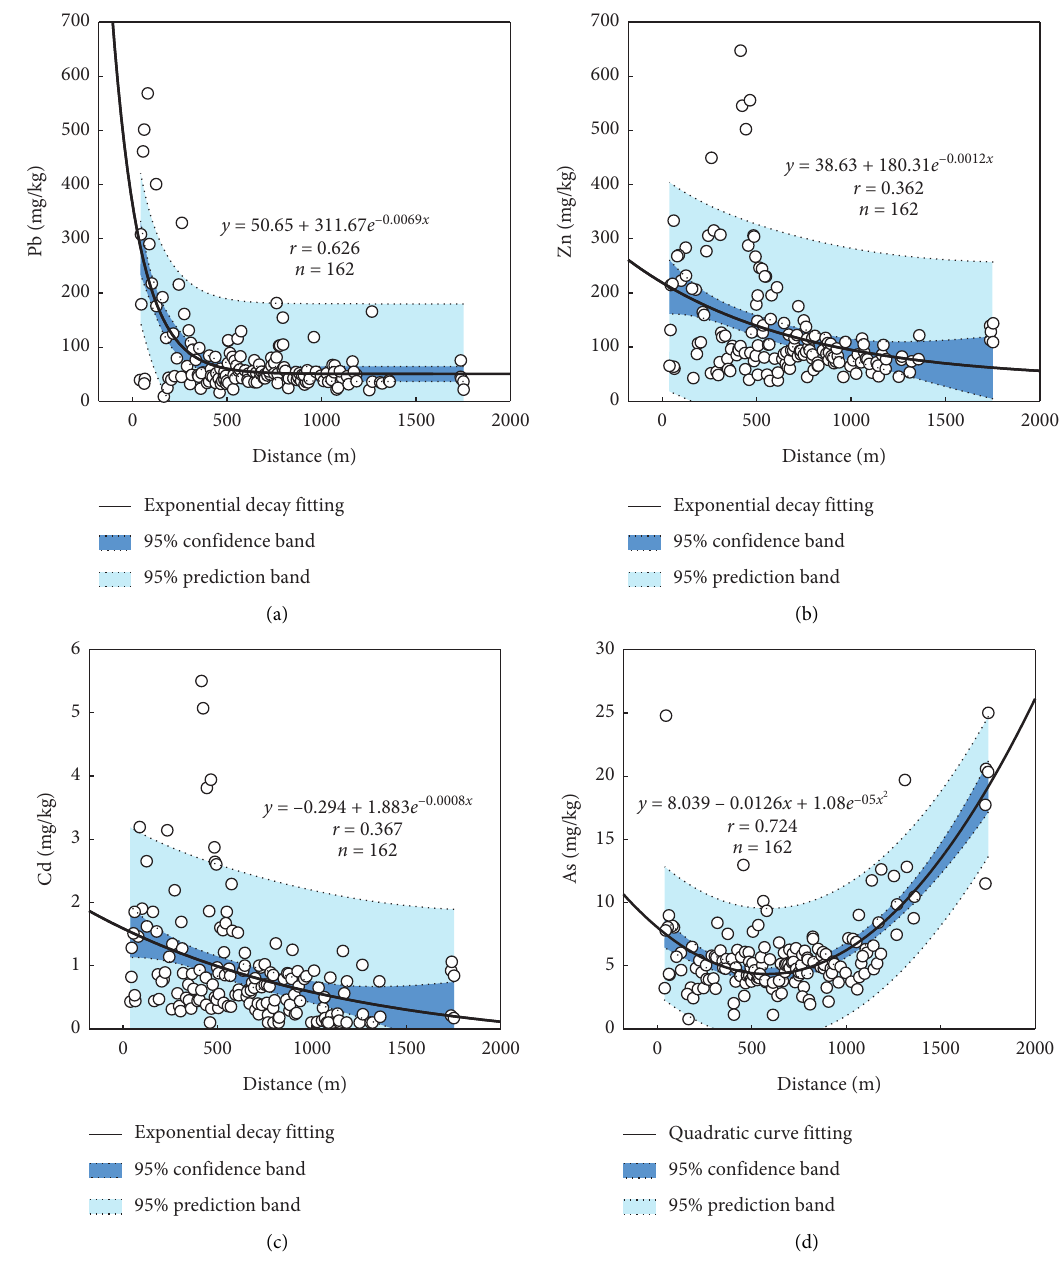
Figure 3: Scatter plots of metal(loid) concentrations in agricultural soils ( n � 162) corresponding to an increasing distance from the mine tailing dumps for (a) Pb, (b) Zn, (c) Cd, and (d) As. The trend lines and 95% confidence (blue) and prediction (sky blue) bands are shown for the regressions. All p values ( < 0.0001) for the F -test in ANOVA were less than the specified significance level